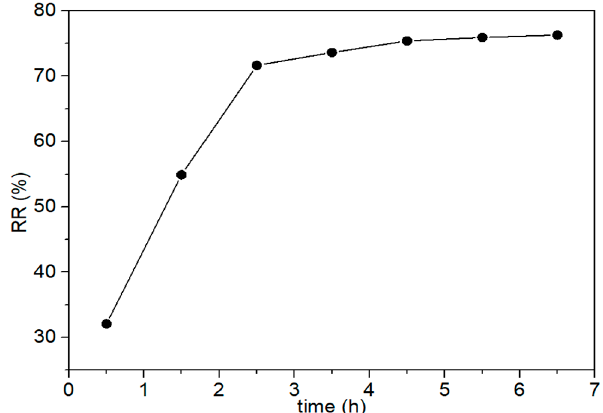
Figure 8. Removal of chloramphenicol. Reaction conditions: 20 mg/L chloramphenicol solution 40 mL, P-POPs-3 10 mg, dark reaction 0.5 h, light reaction 6 h.